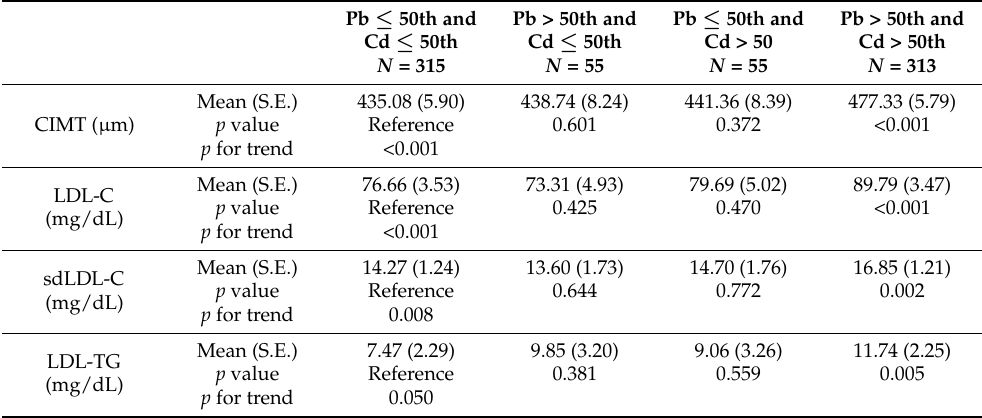
Table 3. Mean of CIMT, LDL-C, sdLDL-C, and LDL-TG in different lead and cadmium subgroups in the linear regression